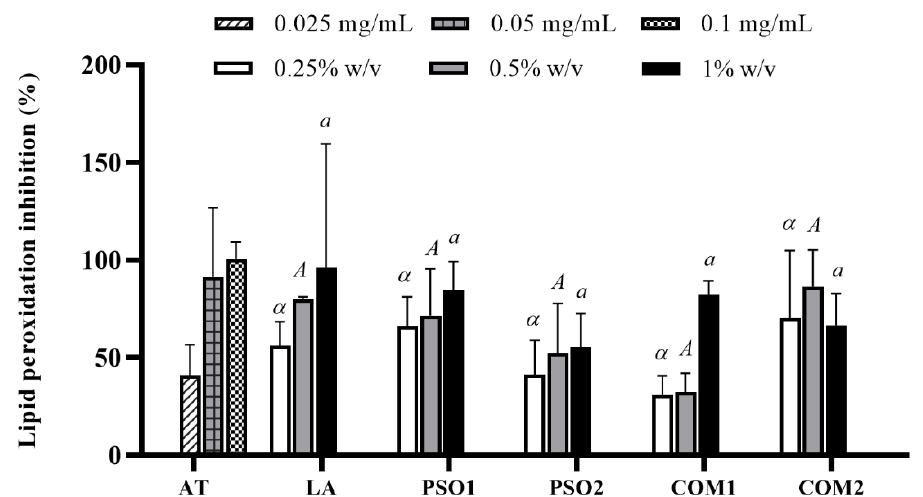
Figure 4. Lipid peroxidation inhibitory effect of pumpkin seed oil samples (PSO1, PSO2, COM1, COM2), linoleic acid (LA), and α-tocopherol (AT). Data obtained from triplicate and three independent experiments are expressed as mean ± SD. The same symbol ( α ) or the same letters ( A or a ) denotes no significant difference among samples at the same concentration, p < 0.05.